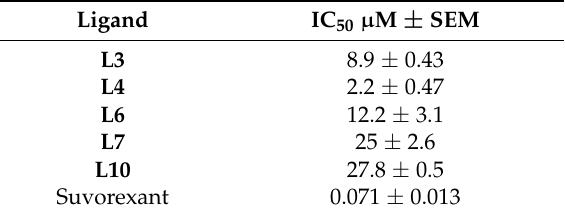
Table 3. Antagonistic effect of ligands, L3 , L4 , L6 , L7 , and L10 , and suvorexant in orexin A-OX2R interaction. IC 50 values were calculated as mean ± SEM (n = 3) 1